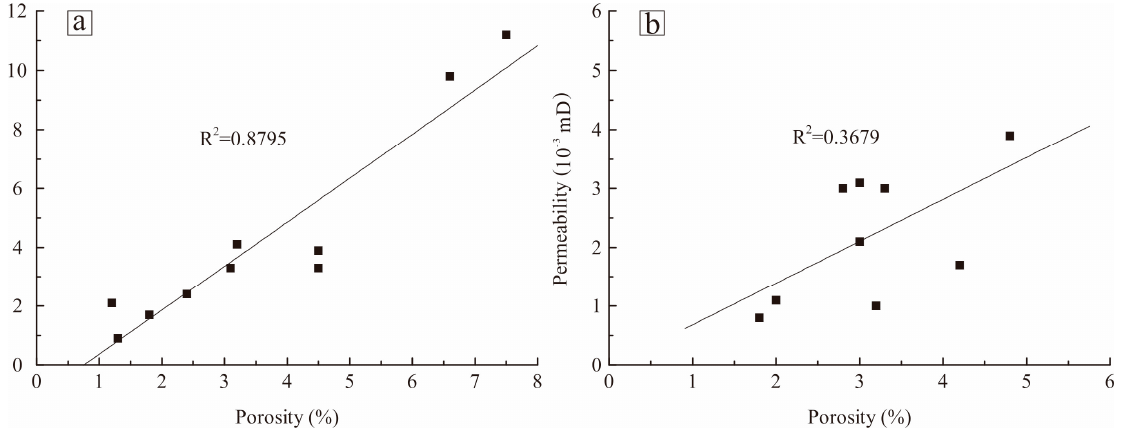
Figure 9. Relationship between the porosity and permeability of the shales from ( a ) SQ1 and ( b ) SQ2.